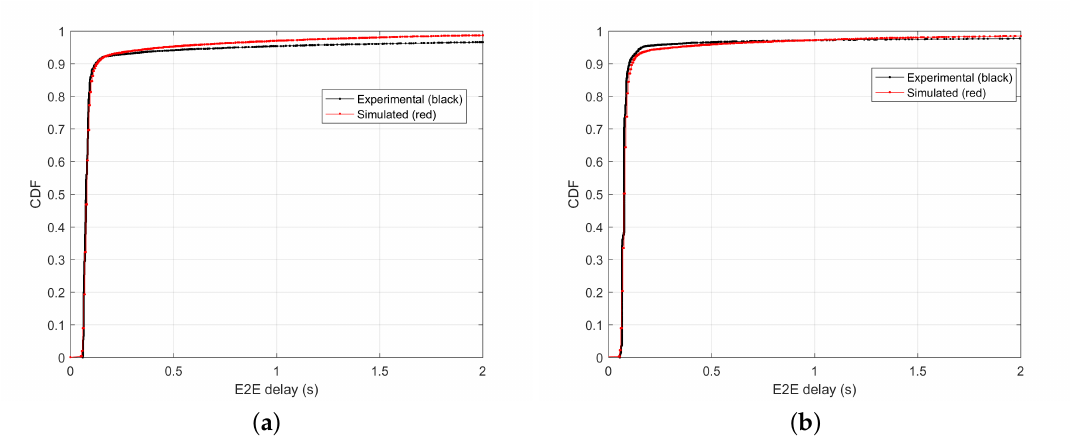
Figure 15. Comparison of E2E delay CDF generated from the model after collecting E2E delays of each generated sample: Expanded time scale up to 2 s, two different experimental samples of the same railway section (all available radio access